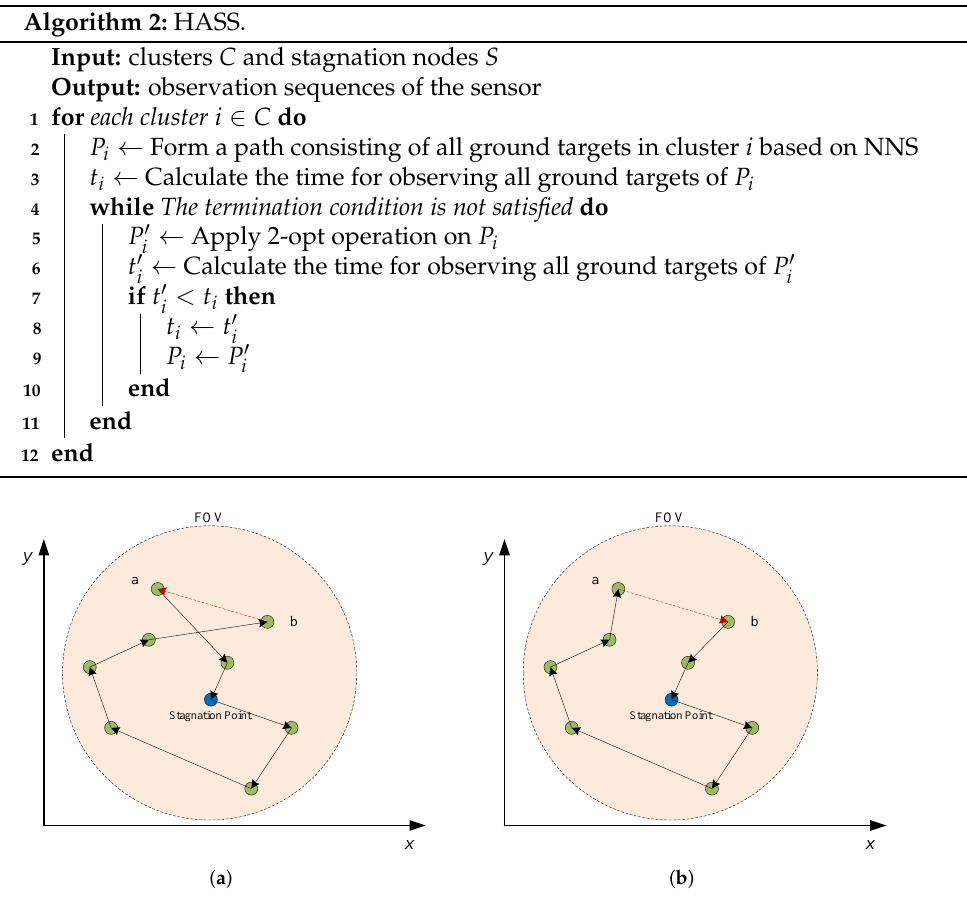
Figure 4. An illustration of the 2-opt operation. ( a ) A path before 2-opt operation, ( b ) A path after 2-opt